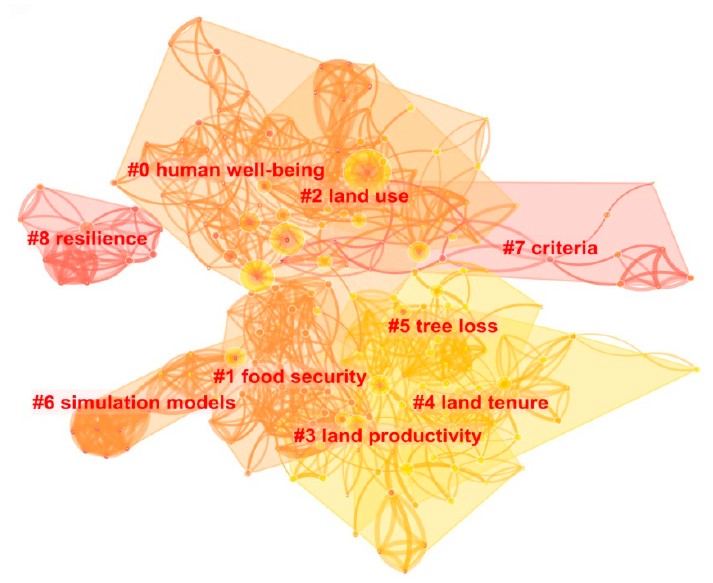
Figure 10. Clustering analysis of co-cited references.